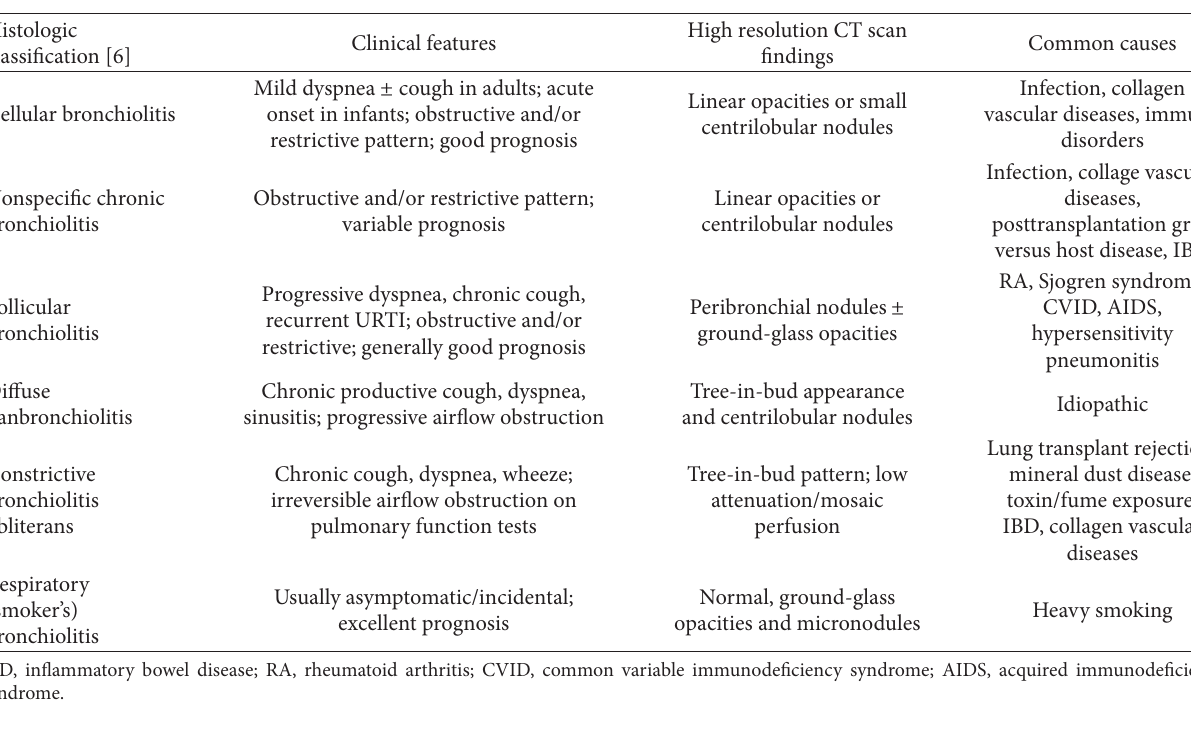
Table 1: Clinical, radiological, and pathological findings in the common small airways diseases [1, 3, 4, 6, 11, 15].